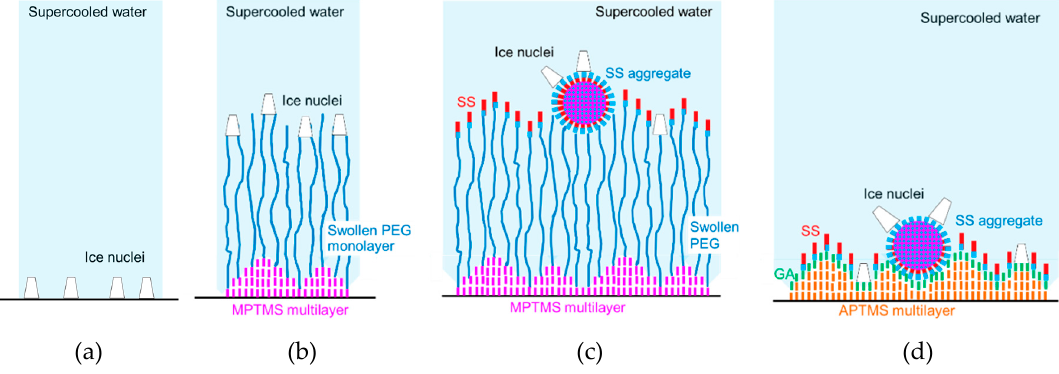
Figure 6. Locations of ice nuclei on the specimen surfaces: ( a ) Glass ; ( b ) PEG ; ( c ) PEG-SS ; ( d ) GA-SS . Blue and green colors show more hydrophilic materials or surfaces, while red, pink and orange colors show more hydrophobic materials or surfaces.